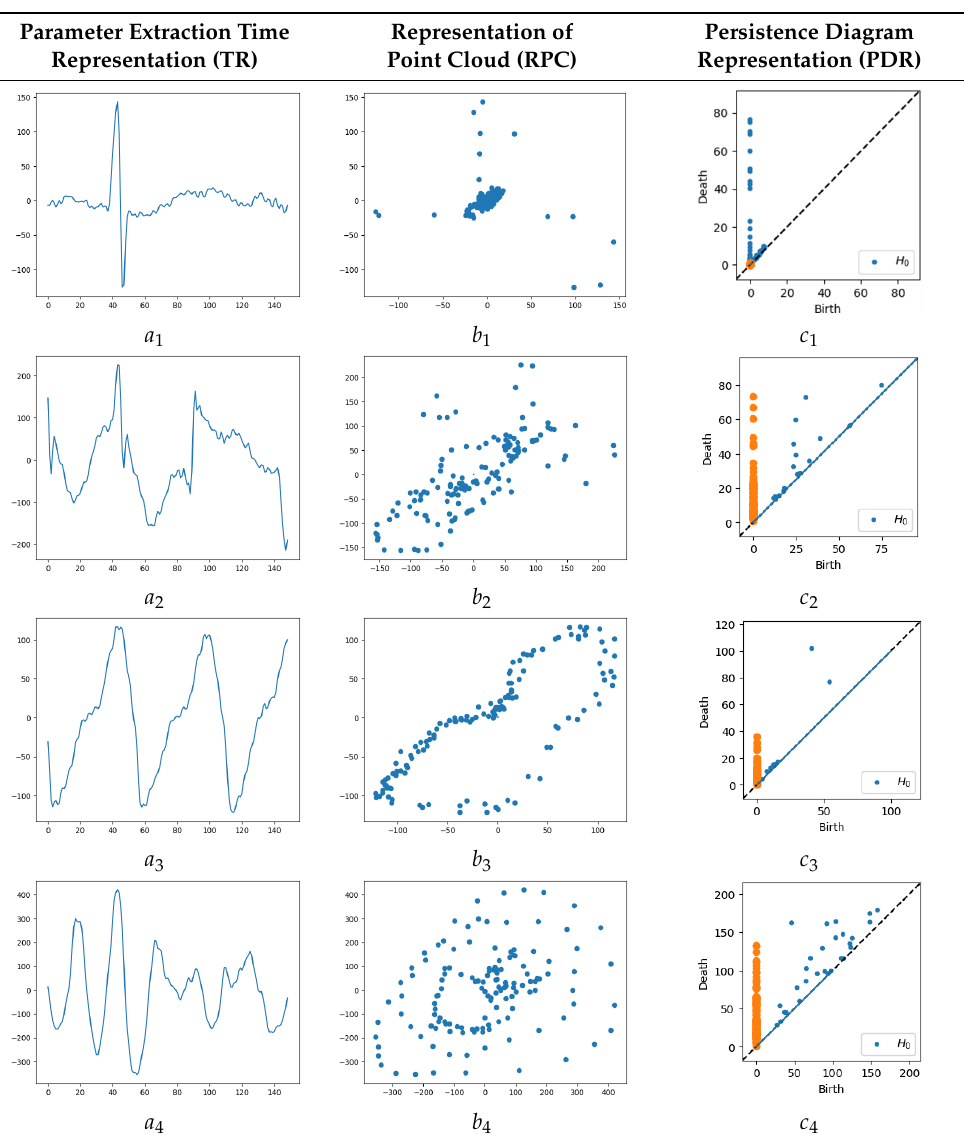
Table 1. Columns a 1 , a 2 , a 3 and a 4 correspond to the original ECG time signal windows; columns b 1 , b 2 , b 3 , b 4 and c 1 , c 2 , c 3 and c 4 show RPC and PDR, respectively. Each row, from top to bottom, corresponds to Normal , Other , VT and VF classes,